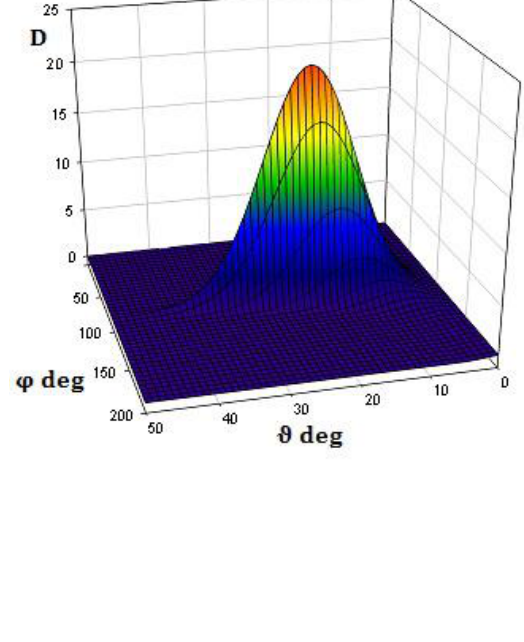
Figure: 4b. The field pattern. f =37.2 GHz,